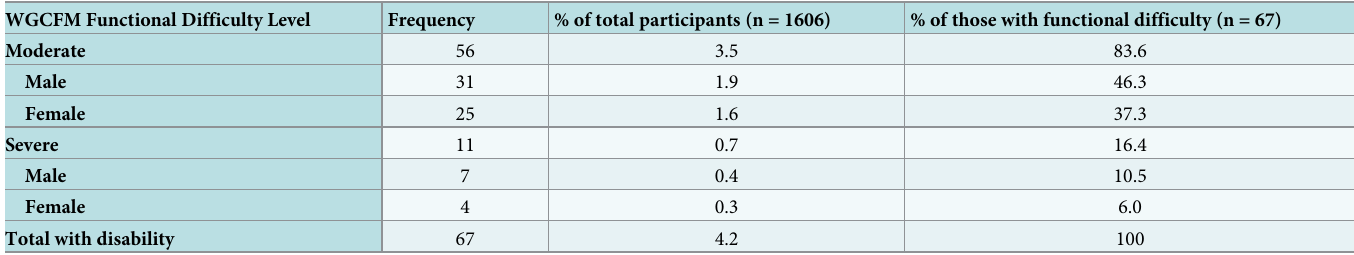
Table 2. Table reporting moderate, severe and total functional difficulty prevalence in HIV unexposed infants.